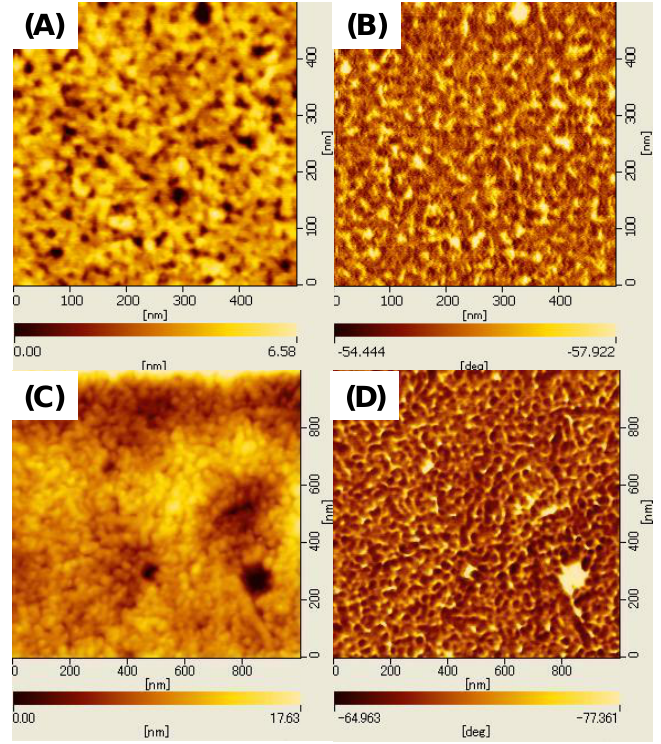
Figure 7. Tapping-mode AFM images of the thin film surfaces of PTVS- b -P3HT- b -PTVS ( A : height image, B : phase image) and PA- b -P3HT- b -PA ( C : height image, D : phase